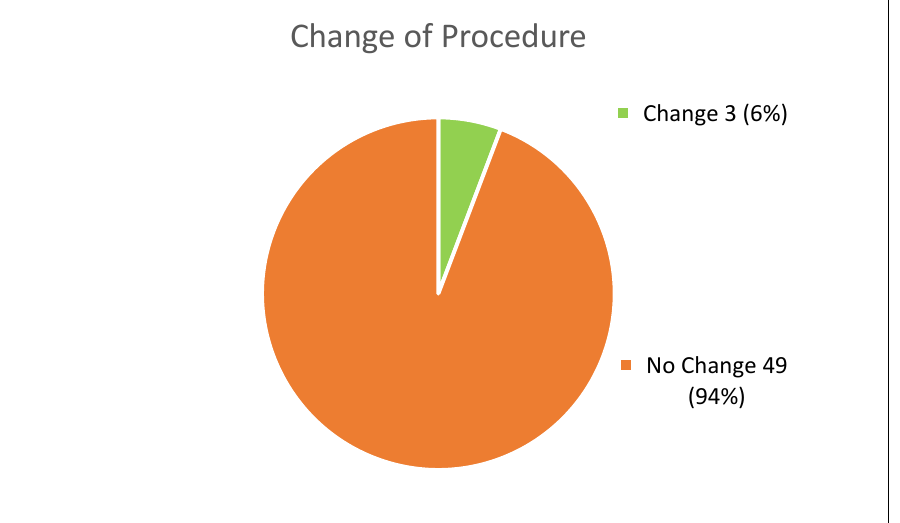
Figure 3. Change of Procedure.